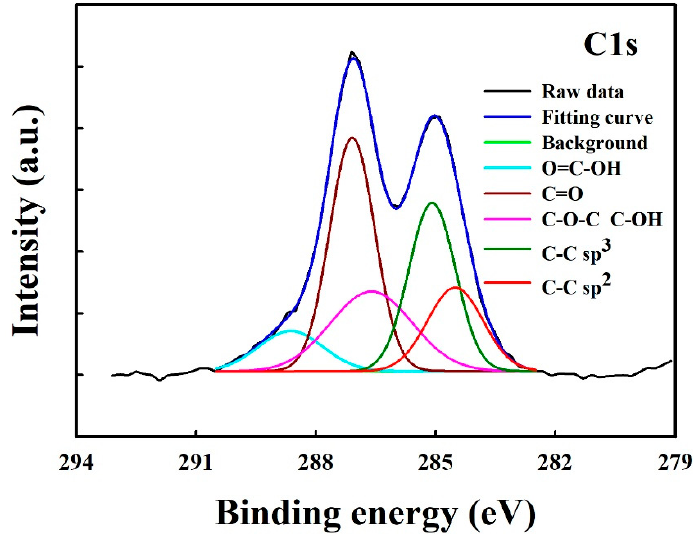
Figure 1. X-ray photoelectron spectroscopy (XPS) spectra of the graphene oxide (GO) layer on the SiO 2 /Pt structure.